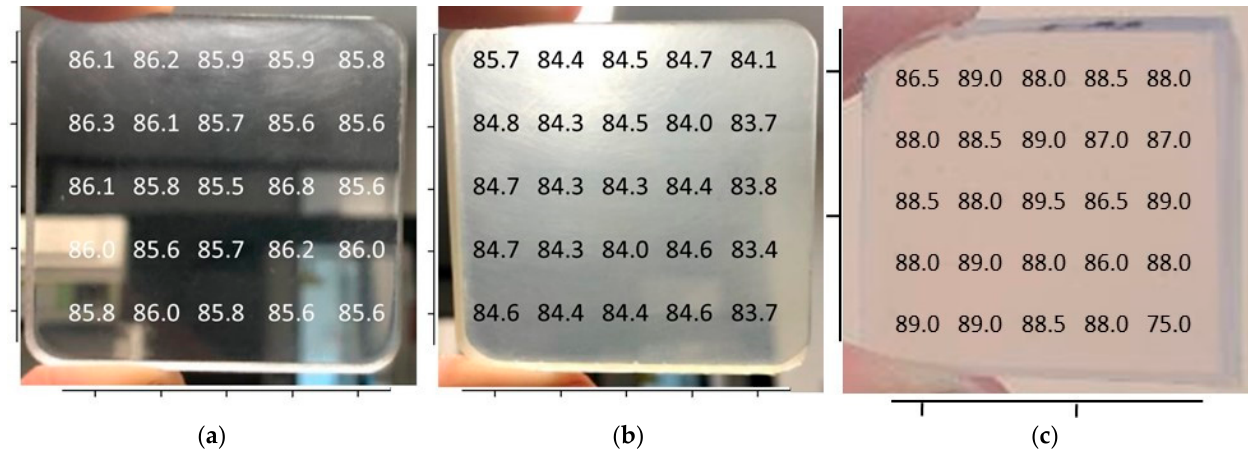
Figure 5. Shore D maps of ( a ) VC, ( b ) SC and ( c ) anti-reflection-coated SC. The scales for the latter are zoomed in, as the piece was cut from the original SC sample. Average values of several measurements were measured over the samples approximately 1 cm apart. The average deviation for each measurement is ±0.5. Despite this size, the VC sample has a detectable higher value compared to SC, consistent with increased hardness after fluorination. On the other hand, the coated SC sample has a measurement significantly higher than VC.